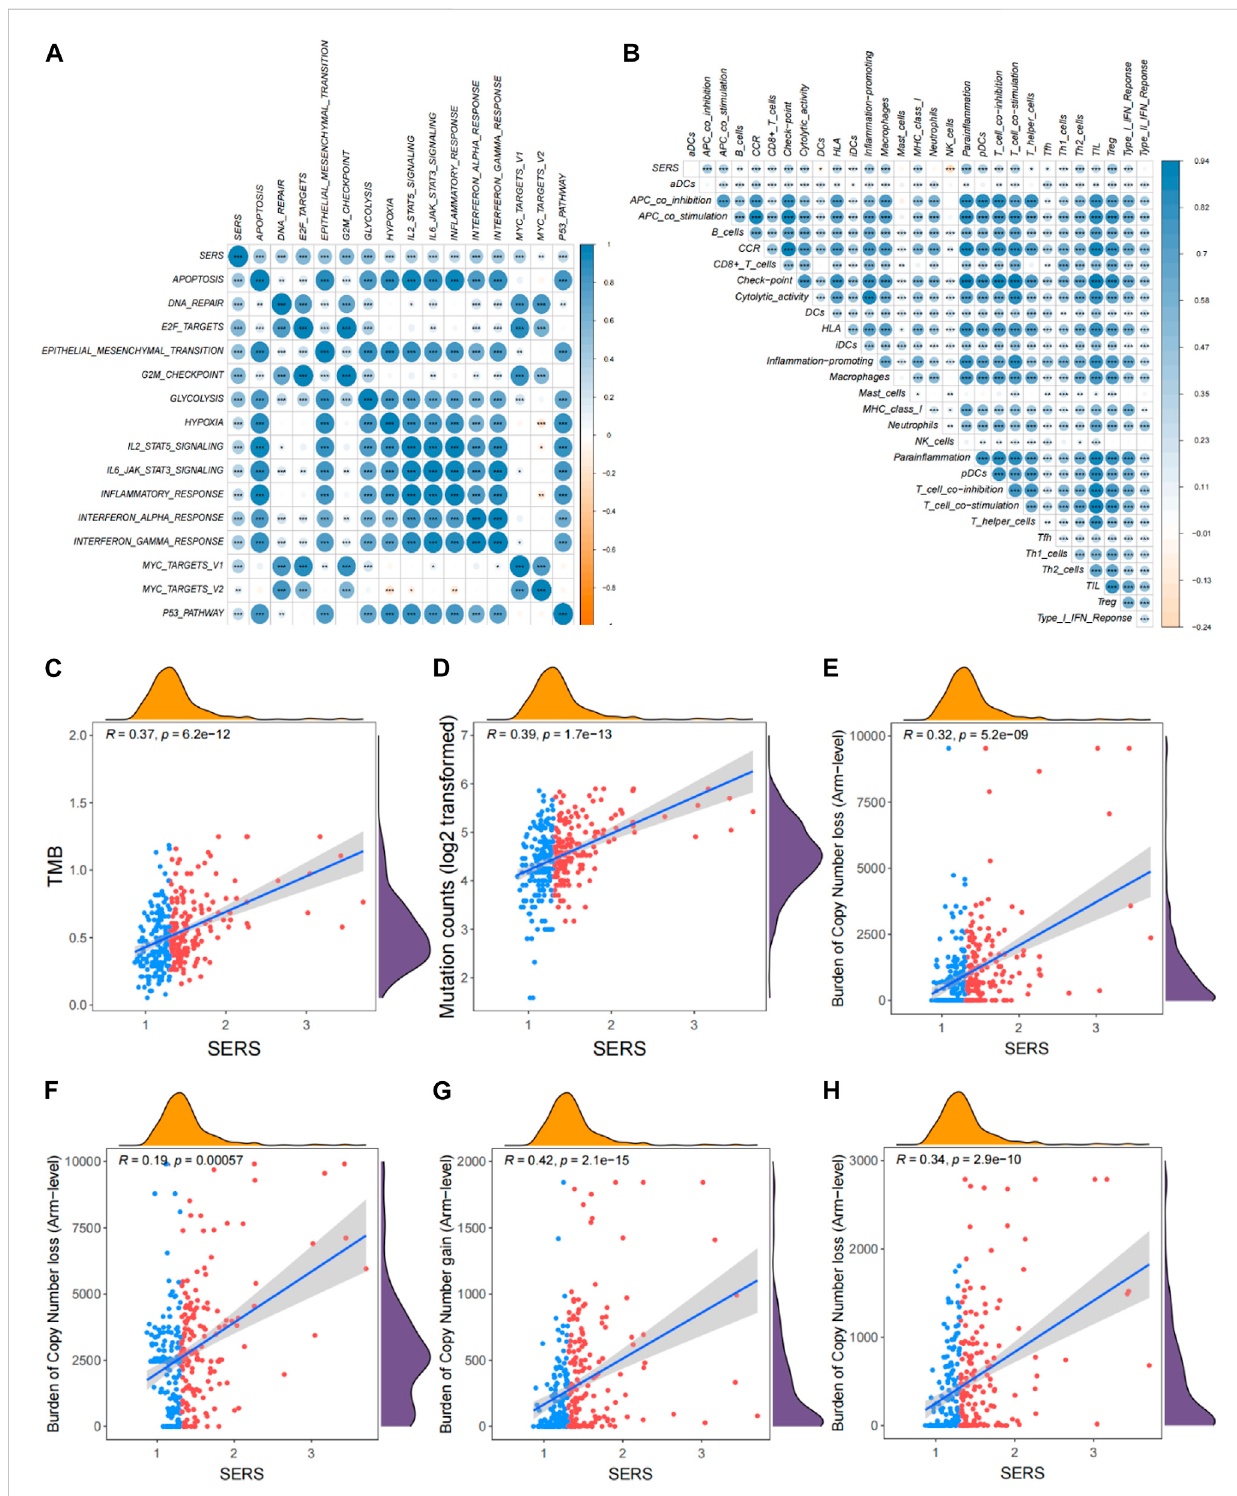
FIGURE 5 Correlation ofSERSwithclinicopathologicalfeatures, genomicalterations andTIMEpatternsinTCGAcohort. (A) Correlation between SERSandthe known cancer hallmarks of LGG patients. (B) Correlation between SERS and the 29 immune signatures. (C – H) Correlation of SERS with TMB, mutation counts, and copy number burdens at focal and arm levels. * p < 0.05, ** p < 0.01, and *** p <